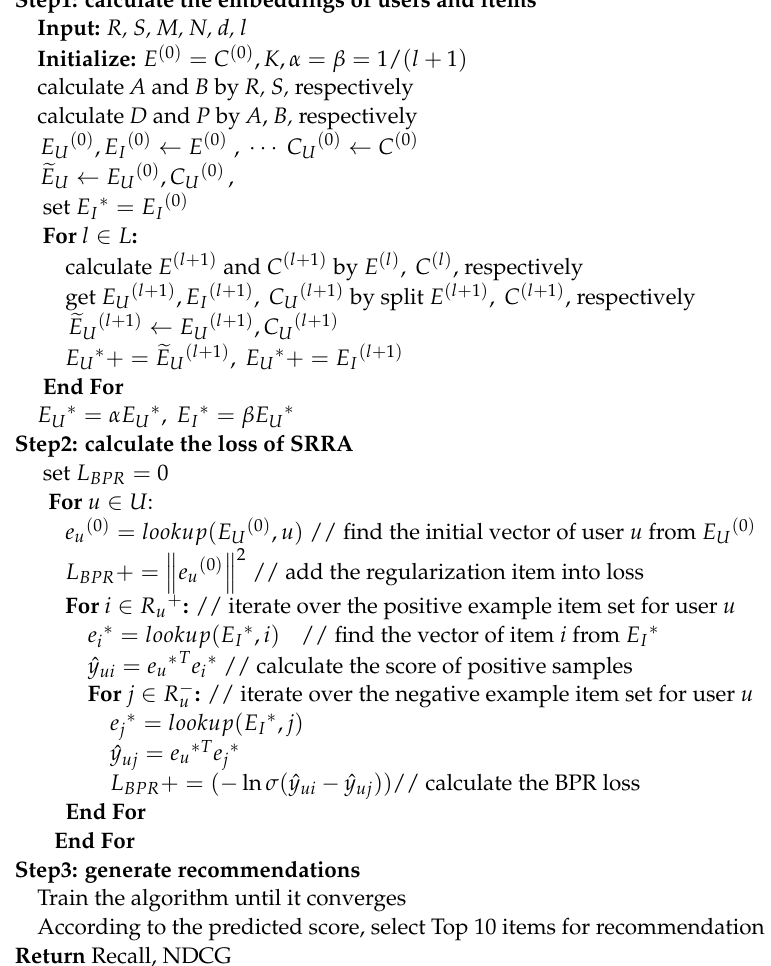
Algorithm 1: Social Relationship Recommendation Algorithm